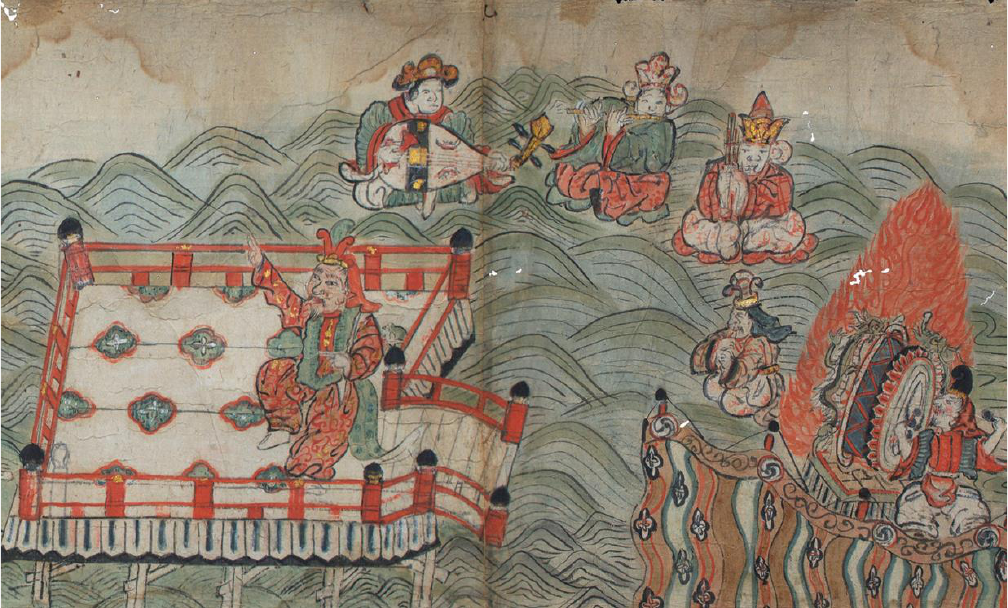
Figure 2. Hachimangū tsūengi 八幡宮通縁起 (Complete story of Hachiman and his shrine, 1431, 1444). Yura Minato Hachiman Shrine, Yura Sumoto City, Hyōgo prefecture. Courtesy of the Hachiman Project, University of Heidelberg. At https://kjc-sv038.kjc.uni-heidelberg.de/hachiman/#O4614.5/, accessed on 15 June 2022.